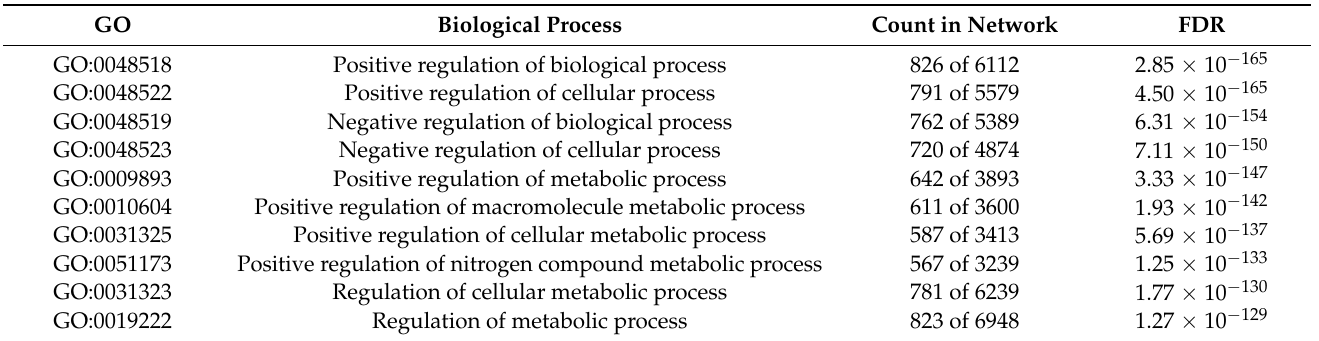
Table 3. Gene ontology analysis of miRNA targets vs. the whole genome; first ten enriched biological